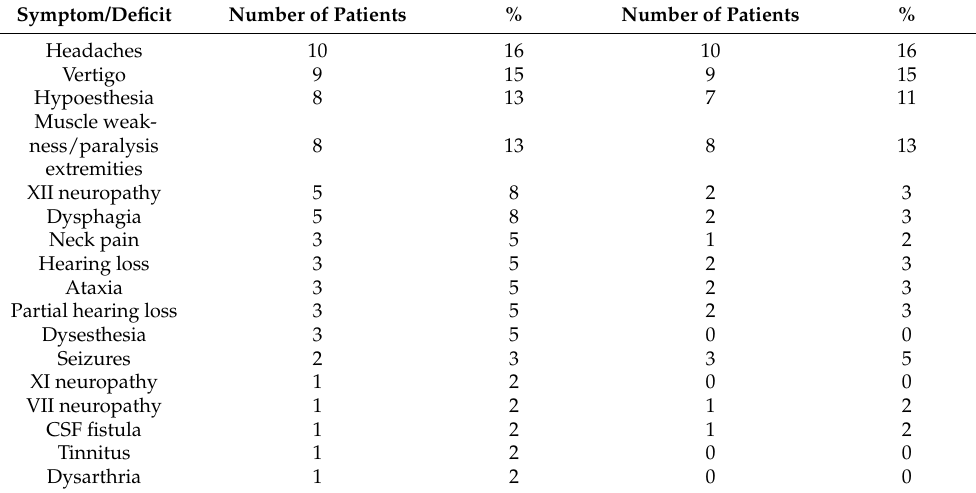
Table 2. Symptoms before SRS (left columns) and at the last available follow-up (right columns). Symptom/Deficit